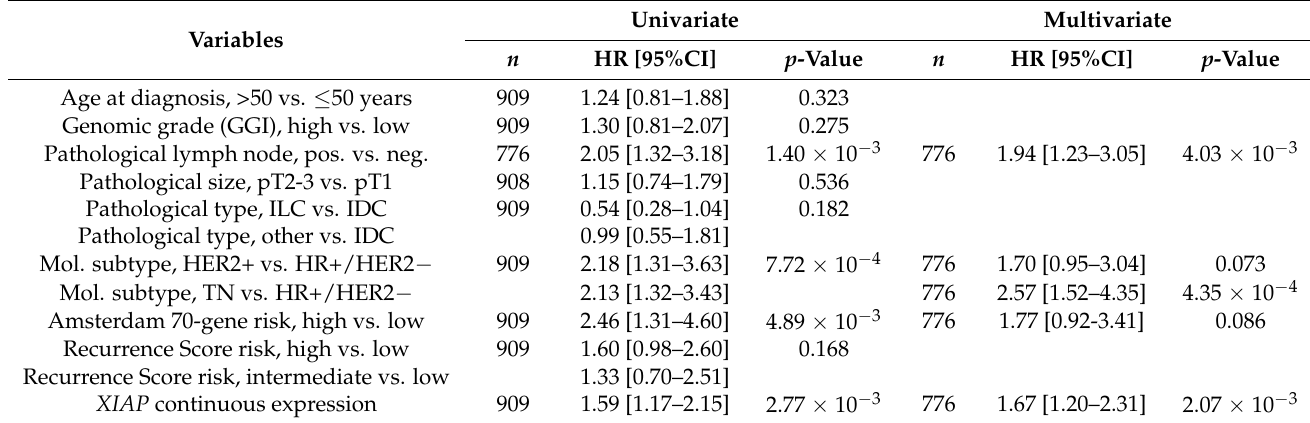
Figure 2. Shorter disease-free survival in high XIAP expression. ( A ) Kaplan–Meier DFS curve in 909 patients. ( B ) similar to ( A ), but according to high and low XIAP mRNA expression (the XIAP-low and XIAP-high groups were defined by the Cox model prediction). ( C ) Kaplan–Meier DFS curve in 347 patients. ( D ) similar to ( A ), but according to high and low XIAP protein expression. Table 2. Univariate and multivariate analyses for DFS in the “RNA population”.